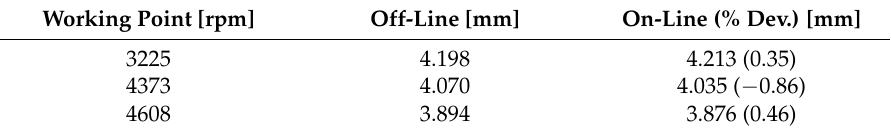
Table 4. Average minimum TC [mm] obtained with the ten-turn-filtered set of signals. Working Point [rpm] Off-Line